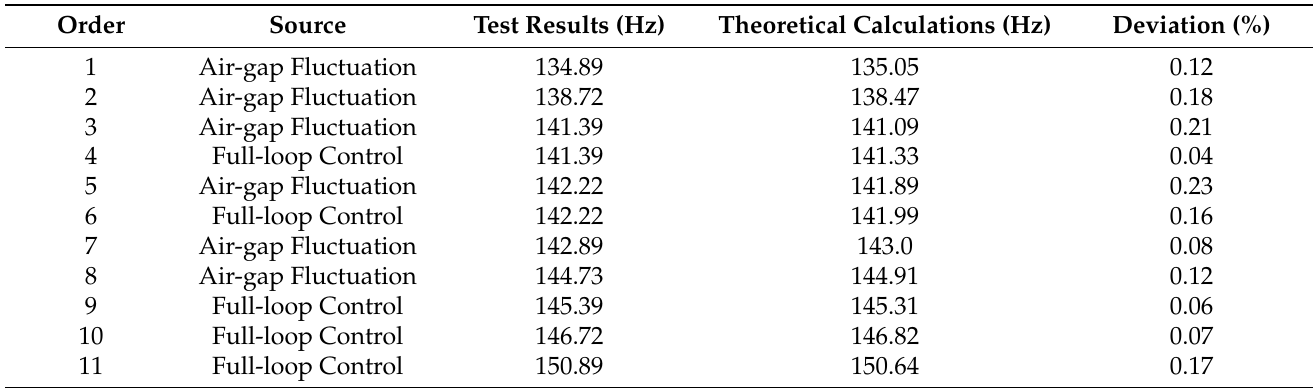
Table 6. The coupling thrust force caused by the third-order cutting